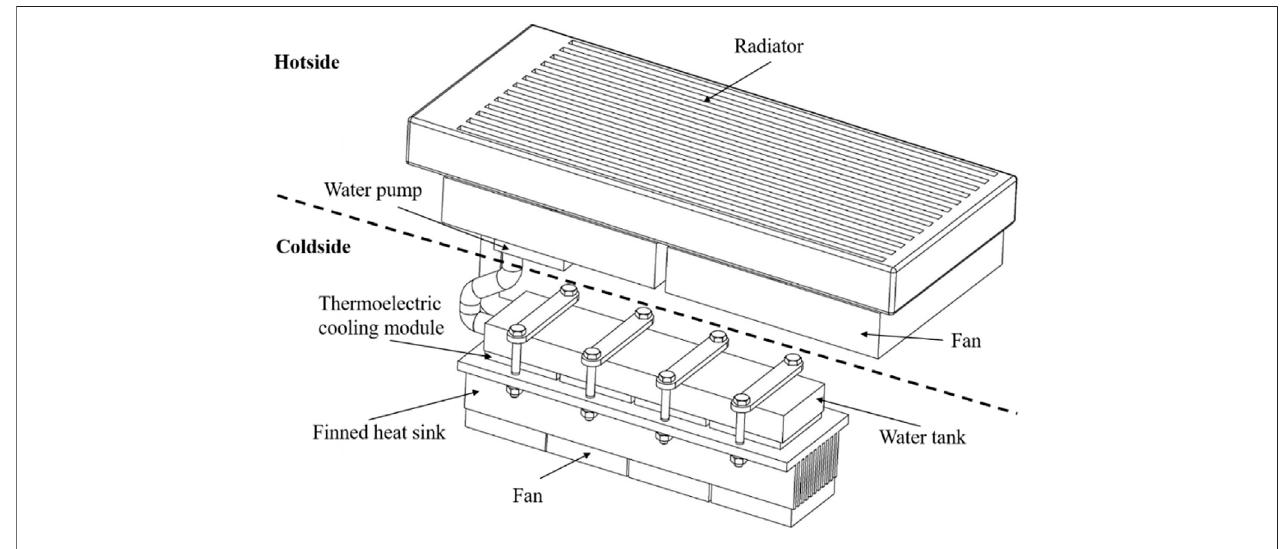
FIGURE 6 | Thermoelectric cooling device model.